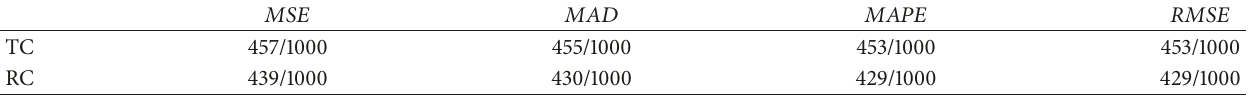
Table 4: Number of paths for which measures of error are higher for monthly steps than for annual steps in GBM. 𝑀𝑆𝐸 𝑀𝐴𝐷